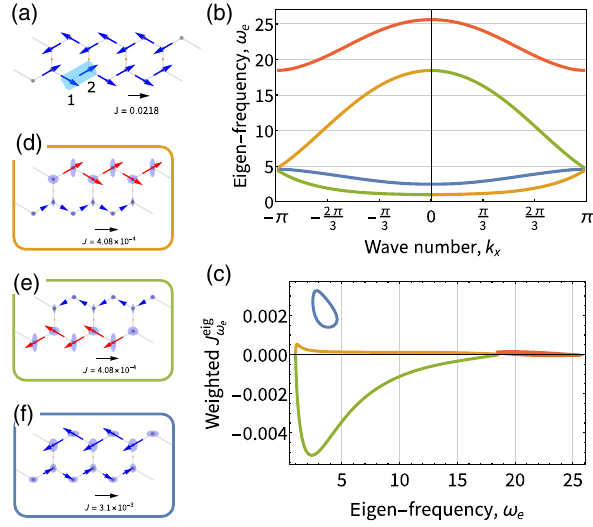
FIG. 7. Using the eigenmode decomposition, we explain how the flux in the honeycomb network is CCW, even though its edge modes contribute to CW fluxes. (a) Network used for calculation, which consists of one row of hexagons (51 unit cells) and has a periodic boundary in the x direction. The parameters are k k ¼ 10 , with others being 1. (b) Band structure of the network (marked with different colors). The yellow or green band contains CW flux localized on the top or bottom edge [an example mode is shown in panel (d) or (e)]. The blue band contains bulk modes with CCW flux [also see panel (f)]. (c) Weighted flux J eig ω to 2 [marked in panel (a)] of the four bands. The total flux in the green band with CW edge modes and that in the blue band with CCW bulk modes are − 0 . 106 and 0.115, respectively. As a result, the net flux is